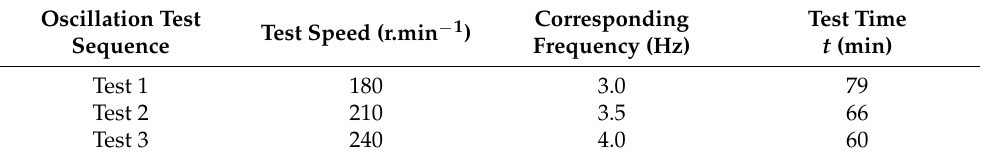
Table 1. ISTA/ASTM Standard Test Method for Simulating Transportation